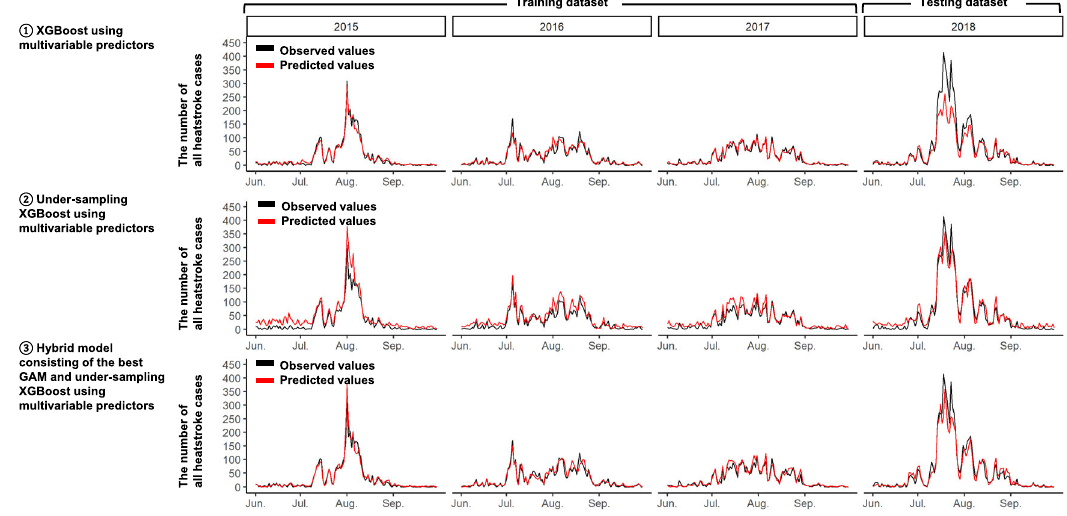
Fig. 2 Comparison between observed and predicted numbers of all heatstroke cases from June to September in 2015, 2016, and 2017 (i.e., training dataset), and 2018 (i.e., testing dataset) by XGBoost models and hybrid model. The black lines indicate the observed total number of heatstroke per day in the 16 Japanese cities, and the red lines indicate the predicted total number of heatstroke per day in the 16 Japanese cities obtained from the following prediction models: (1) XGBoost using multivariable predictors, (2) Under-sampling XGBoost using multivariable predictors, and (3) Hybrid model consisting of the best GAM and under-sampling XGBoost using multivariable predictors. GAM generalized additive model, XGBoost extreme gradient boosting decision